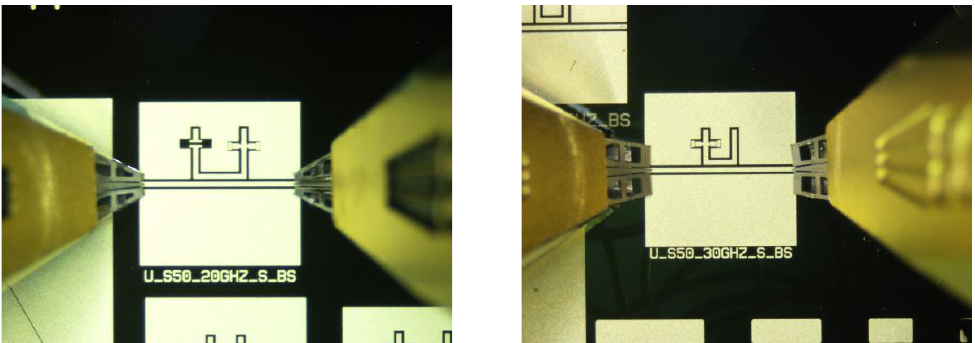
Figure 6. On the left is the 20 GHz resonator and, on the right, the 26 GHz one, where the switches are technologically actuated (completely collapsed beam) or not technologically actuated (beam re- moved).